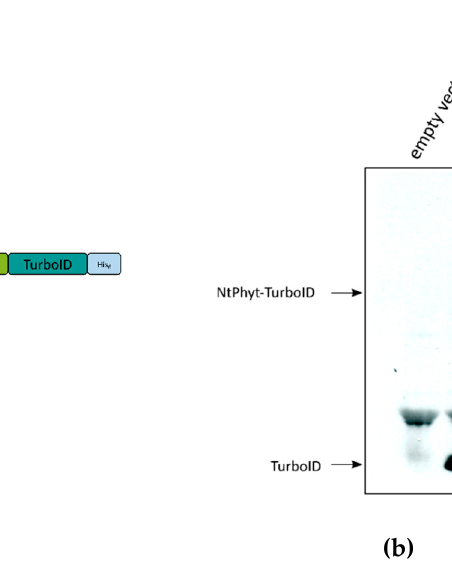
Figure 1. Nicotiana tabacum phytaspase ( Nt Phyt) ‐ TurboID and signal peptide (SP) ‐ TurboID proteins utilized for the identification of phytaspase interactors. ( a ) Schematic representation of recombinant proteins. Non ‐ specific biotin ligase TurboID fused to SP derived from Nt Phyt served as a control for in planta biotinylation accomplished by Nt Phyt ‐ TurboID protein. Both proteins bear His tags to permit their detection using Western blotting analysis. ( b ) Transient production of Nt Phyt ‐ TurboID and SP ‐ TurboID in N. benthamiana leaves. Protein extracts from Nt Phyt ‐ TurboID ‐ producing, SP ‐ TurboID ‐ producing and control (vector) leaves were fractionated by sodium dodecyl sulphate (SDS) gel ‐ electrophoresis and analysed by Western blotting with HisProbe detection. Positions of molecular weight protein markers are indicated on the right.